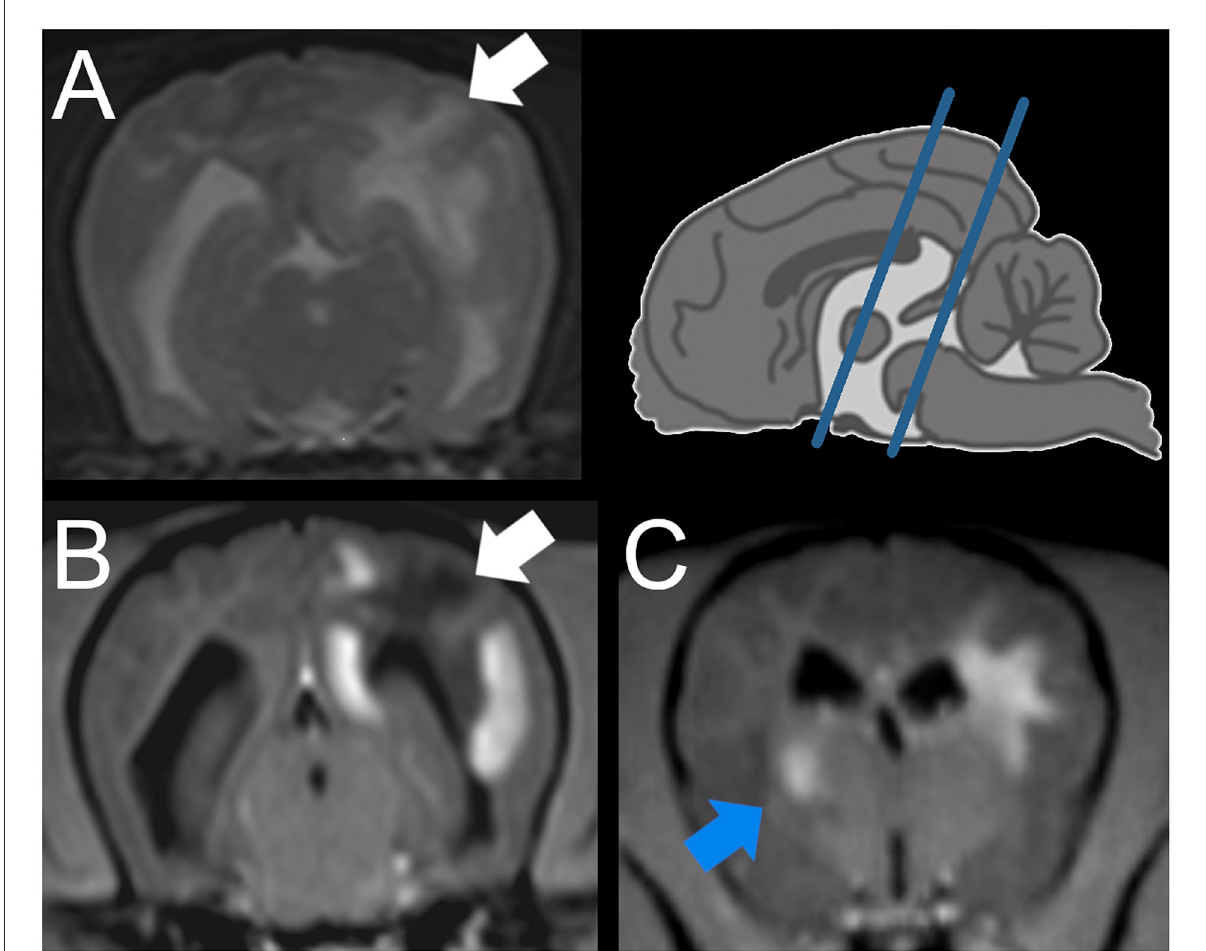
FIGURE1 Magnetic resonance imaging (MRI) of a Yorkshire Terrier with meningoencephalitis of unknown origin (case 1). Transverse plane at the level of the mesencephalon (A,B) and interthalamic adhesion (C) (see blue lines in the schematic overview upper right), A: T2 weighted (w), B, C: T1w post contrast injection. Intraaxial lesion of the subcortical white matter of the cerebral hemisphere, identified on histopathology as predominantly necrotic ( A,B : white arrow). Intraaxial lesion of the striated body identified as granulomatous lesion ( C : blue